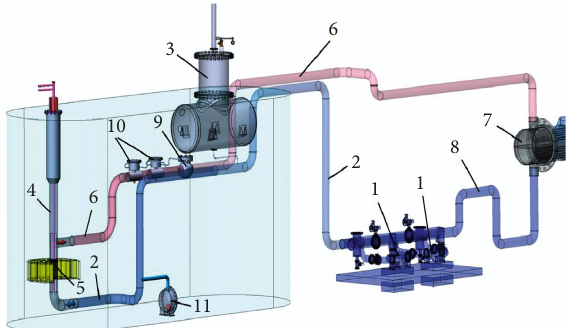
Figure 5: External view of the first core cooling circuit of a high-flow reactor plant. (1) circulation pumps; (2) pressure “cold” pipeline; (3) pressure compensator; (4) reactor vessel; (5) core; (6) outlet “hot” pipeline; (7) steam generator; (8) suction pipeline of pumps; (9) check valve; (10) exhaust valves of natural circulation; (11) inlet valve of natural circulation.